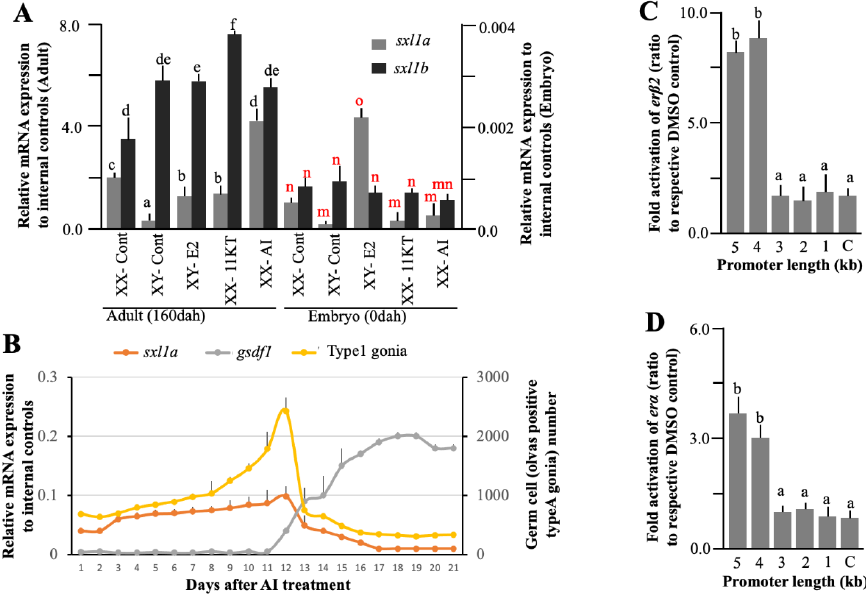
Figure 6. Effects of sex steroids on sxl1 regulation in medaka. In vivo analysis, using E2 (1ng/mL), 11-KT (10ng/mL), and AI (25ng/mL) depicted a strong and significant alteration of sxl1a but rela- tively mild changes of sxl1b in both adult gonad and embryos (experimental replicate = 4). Steroid concentrations were adjusted using pilot experiment ( A ). Further in-depth analysis using AI-treated mature adult XX female demonstrated a strong positive correlation (0.88) between sxl1a and germ cell population ( B ). gsdf1 expression was assessed to measure the masculinization of the female. Data are shown as the mean ± SEM and expressed as relative abundance corrected for the average of ef1 α , β actin , and rps18 ; different letters denote significant differences at p < 0.05. In vitro promoter analysis under the influence of er β 2 ( C ) and er α ( D ) of sxl1a showed estrogen/ ER -dependent modulations. The luciferase activity of E2-treated samples were normalized with their respective DMSO control, and the mean relative fold activations were plotted in the graph. C—promoter-less control; experimental replication—6; different letters denote significant differences at p <